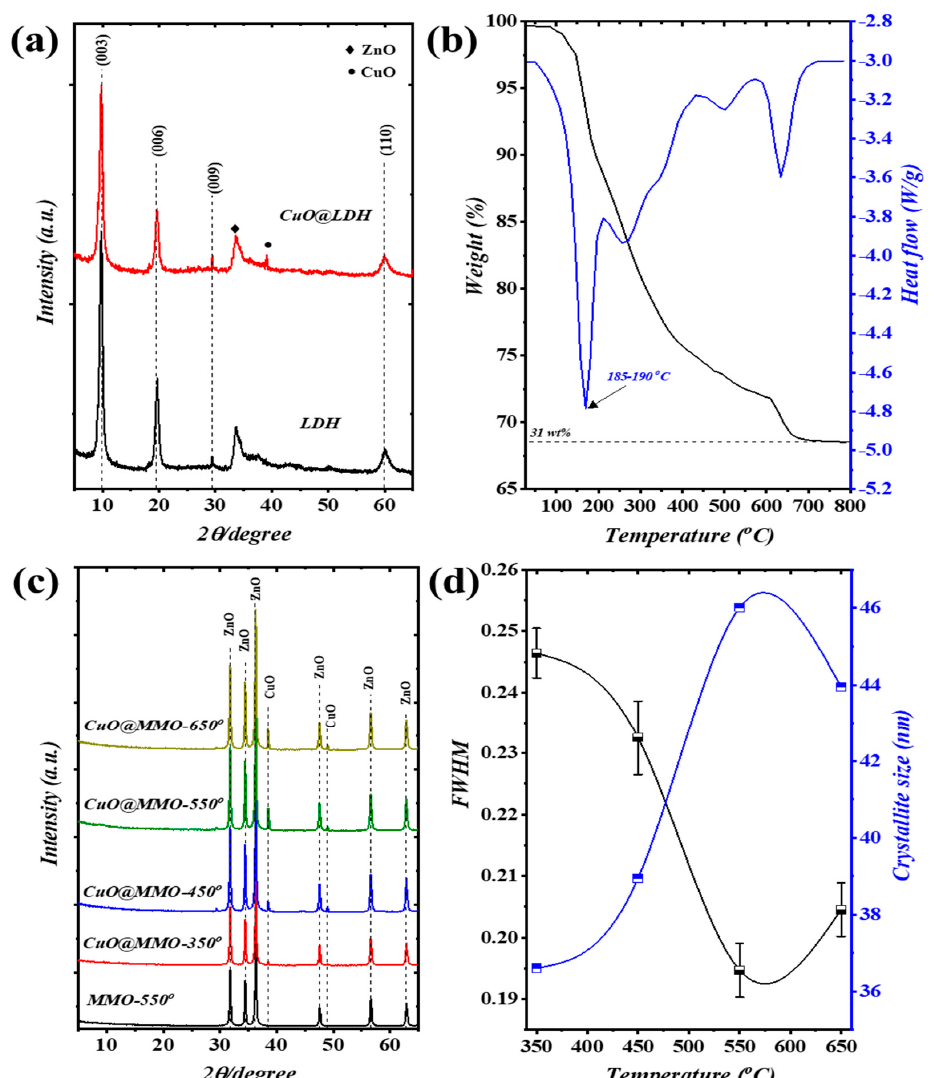
Figure 1. ( a ) XRD patterns of LDH and CuO@LDH, ( b ) TGA/DTG results of CuO@LDH, ( c ) XRD patterns, and ( d ) FWHM and crystallite size of the CuO@MMO-T films.